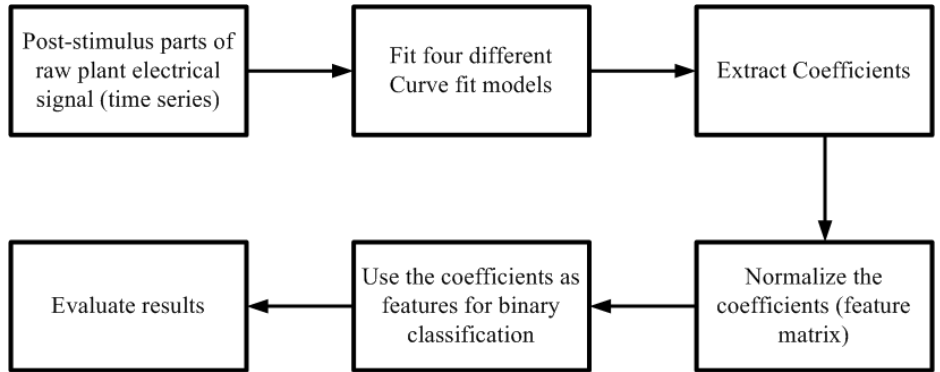
Figure 2. Classification using Curve fit coefficients.